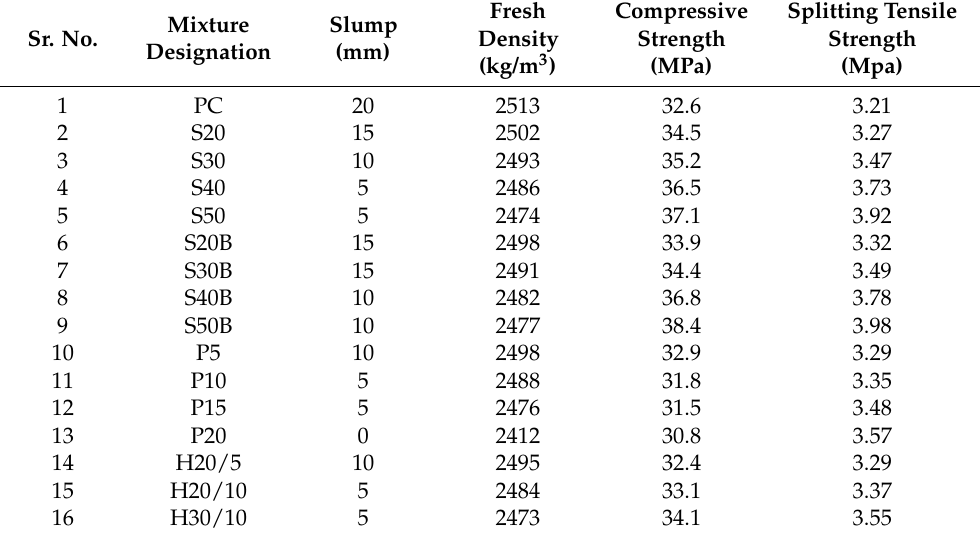
Table 4. Results of various